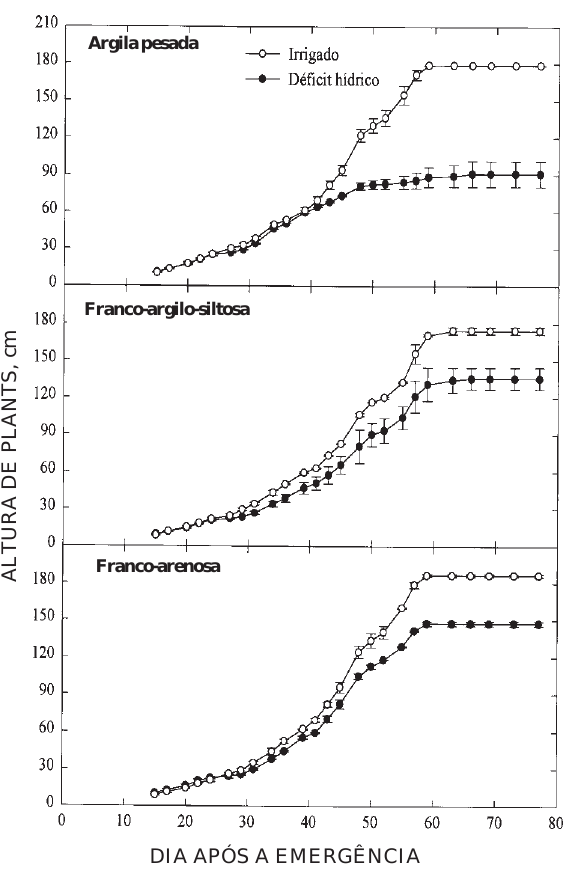
Figura 4. Altura média das plantas de milho submetidas a déficit hídrico e irrigadas em solos de diferentes texturas. As barras verticais representam o